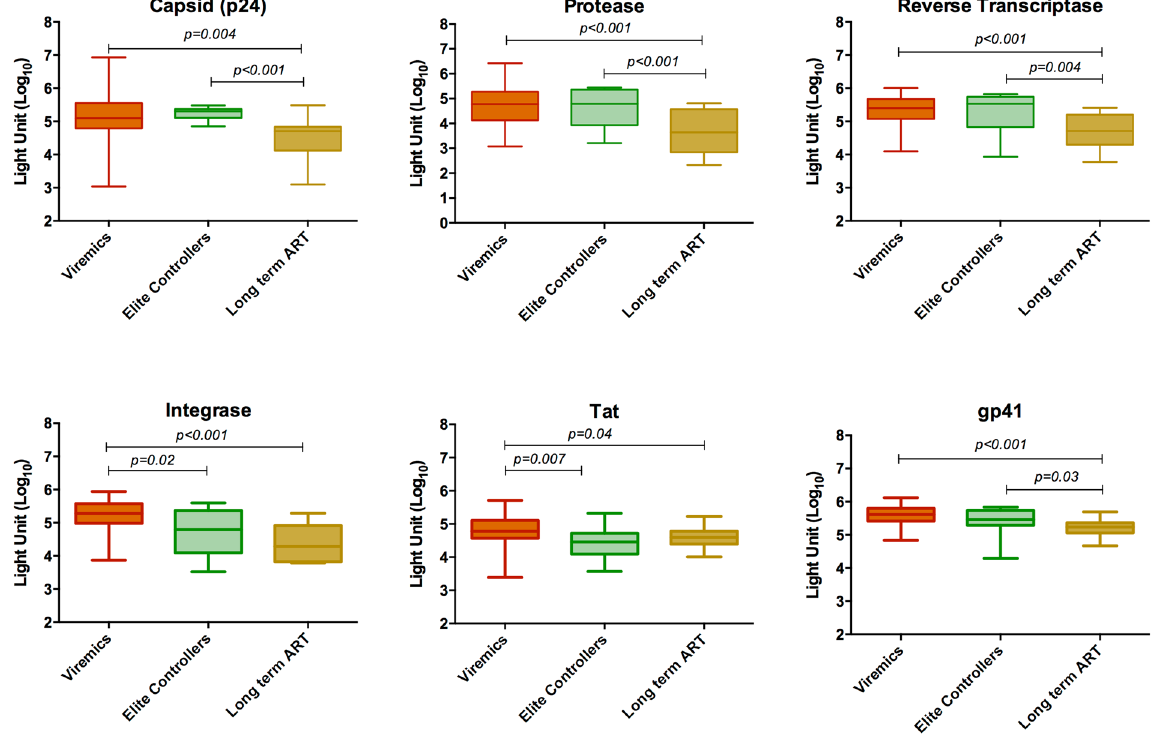
and patients with long-term suppressive ART (n = 19) against capsid (p24), protease, reverse transcriptase, integrase, Tat and gp41. Data indicates a lower response in the long-term suppressive ART group against p24, protease, reverse transcriptase and gp41 compared to the other two groups (Mann Whitney U test; p < 0.05 for all